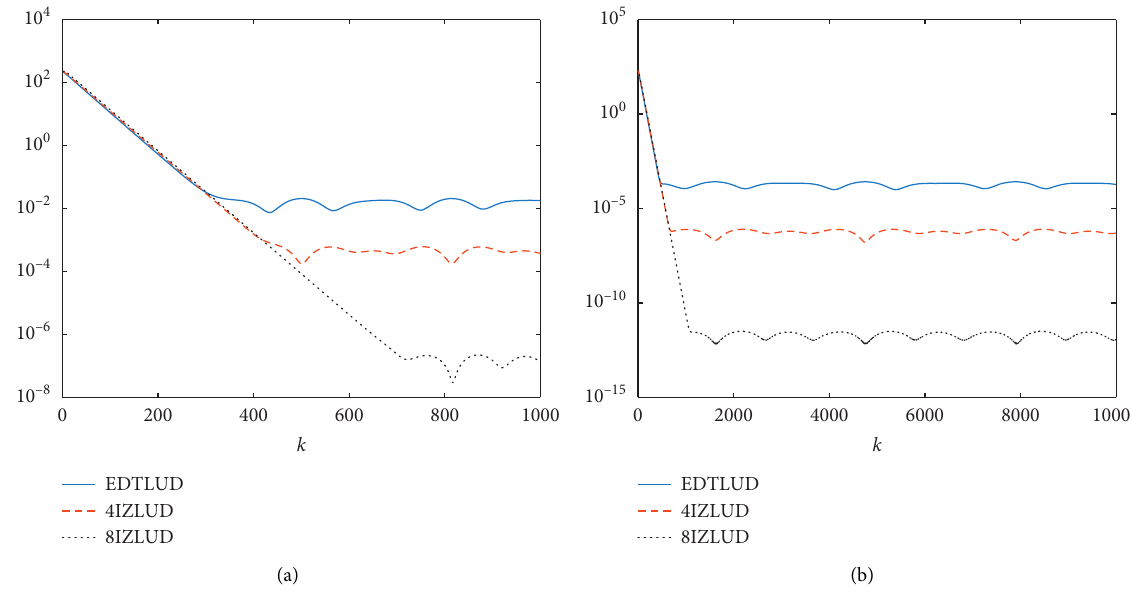
Figure 6: Residual errors of three discrete-time models with g � 0 . 03 and s ( 0 ) � 0 1 0 1 2 3 4 5 6 􏼂 􏼃 T for solving 3-dimensional time- varying LU decomposition problem in Example 2. (a) When η � 0 . 01 s. (b) When η � 0 . 001 s.